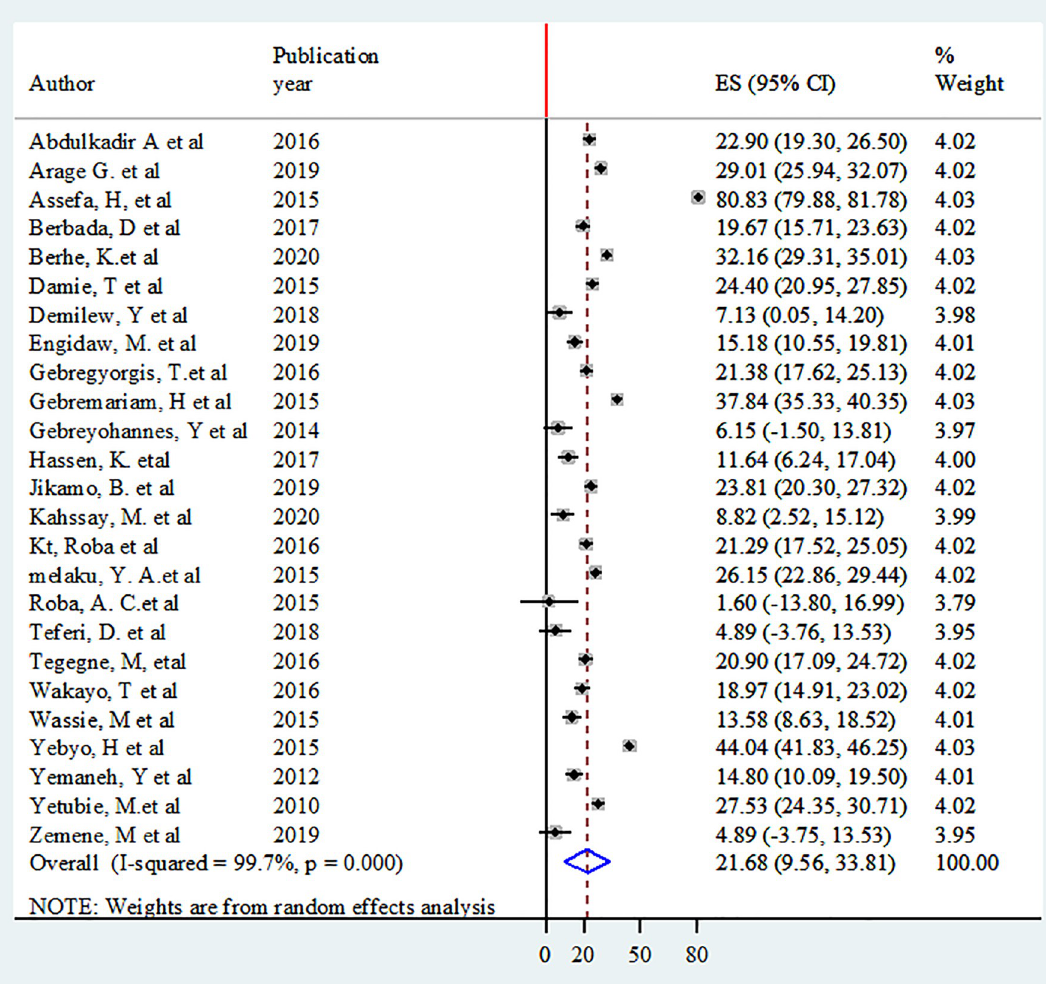
For stunting, six associated factors were used in the quantitative analysis. Although hetero- geneity was not observed in family size and residence, it was observed among adolescent age, sex, meal frequency and protected drinking water source. Weights were calculated using the random-effects analysis. Adolescent age, sex, and meal frequency were not statistically signifi- cant factors for stunting. Urban adolescences had 18% lower odds of being stunted (OR: 0.82, 95%CI: 0.68–0.99). Adolescents having protected water source for drinking had 50% lower likelihood of stunting (OR: 0.50, CI: 0.27–0.90). Households with family size of < 5 were 46% less likely to be stunted than those with family size of � 5 (OR: 0.54, CI: 0.44–0.66) (Fig 14). Heterogeneity was observed in all the seven factors associated with thinness included in the analysis. Thus, weights were calculated using the random-effects analysis. Sex, residence, meal frequency and DDS were not statistically significant. Early adolescents (age 10-14years) were 2 times more likely to be thin than late adolescent (OR: 2.38, CI: 1.70–3.34). Adolescents with protected water source were 64% less likely to be thin than those adolescents had unprotected water source (OR: 0.36, CI: 0.21–0.61). Likewise, households with a family size of < 5 were 50% less likely to be thin than those who had family size of � 5 (OR: 0.50, CI: 0.28–0.89).